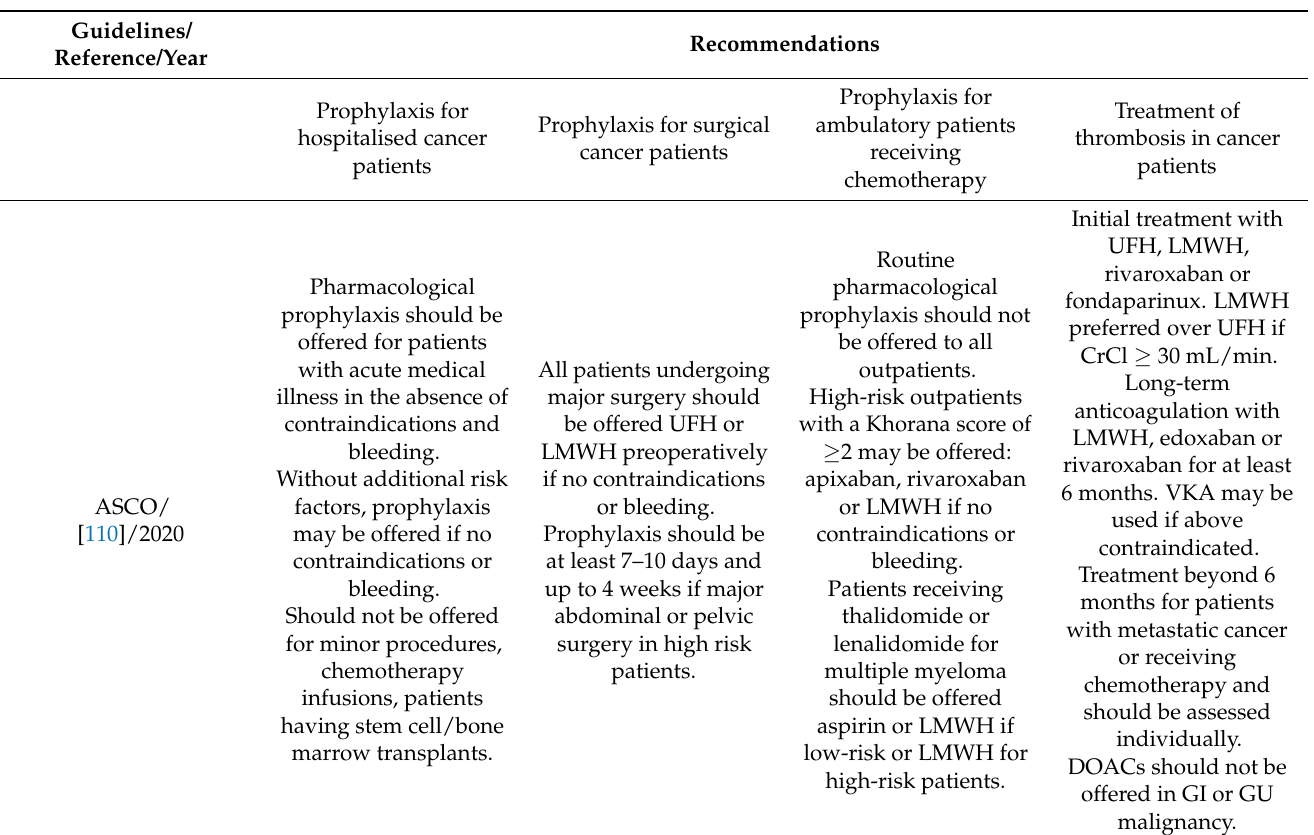
Table 4. Current treatment guidelines for cancer-associated